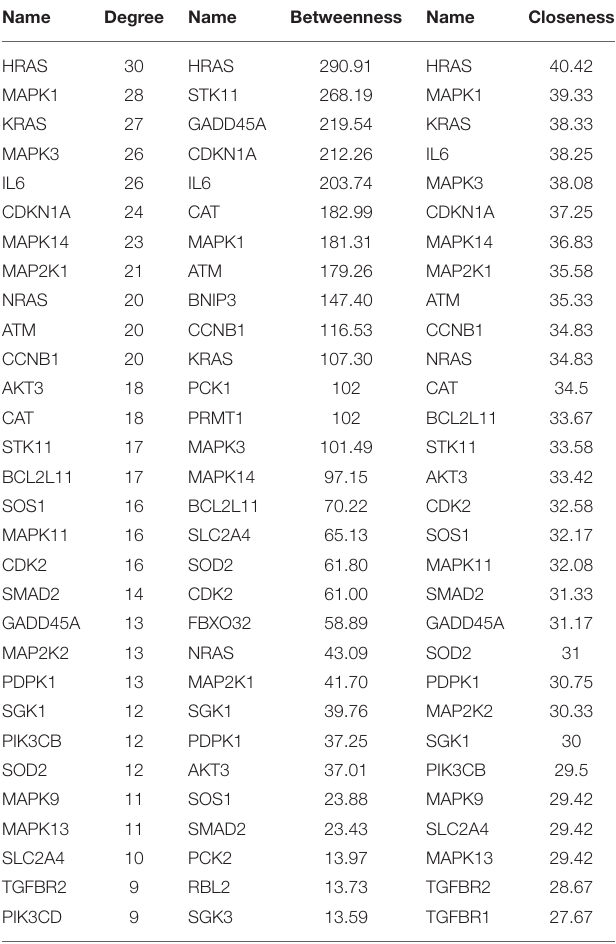
TABLE 5 | Top 30 nodes of PPI network in the FoxO signaling